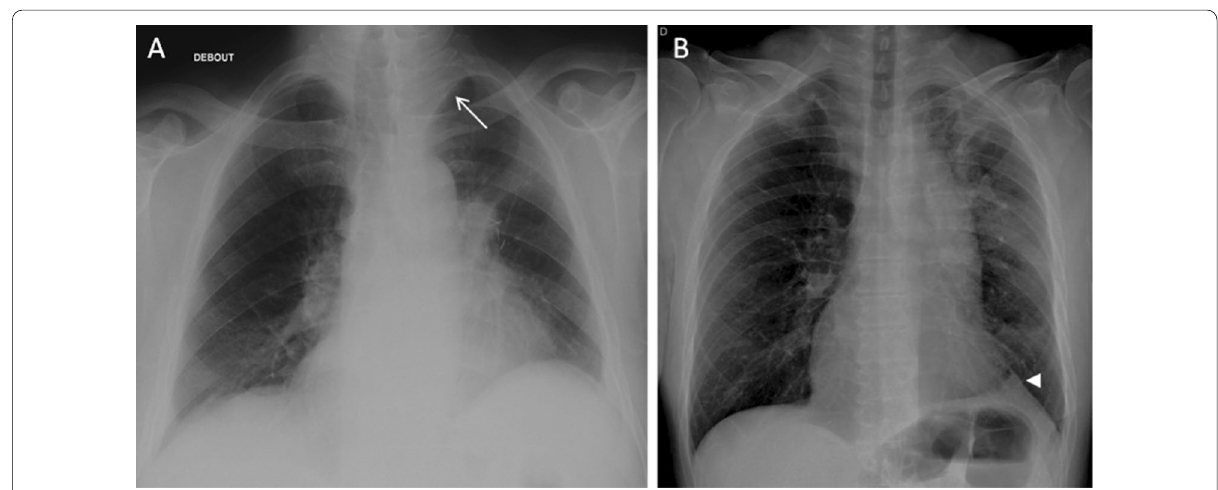
Fig. 3 Lobar pseudo‑collapse and juxta‑phrenic peak sign. A : CXR showing a left upper lobar pseudo‑collapse (white arrow). B : right juxta‑phrenic peak sign (white